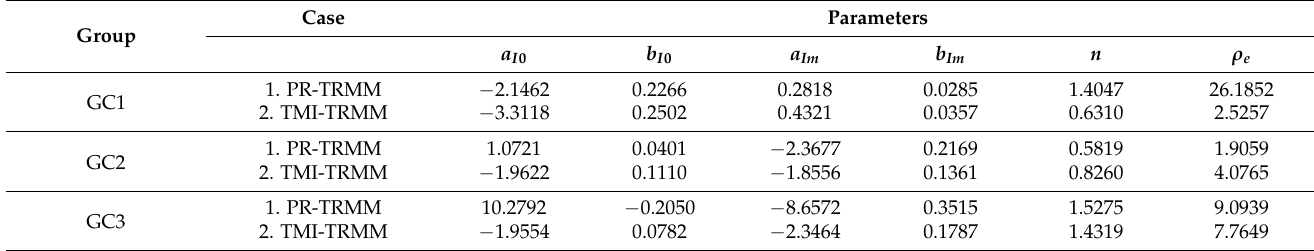
Table 2. Estimated model coefficient for the mean rainfall intensity (see Equation